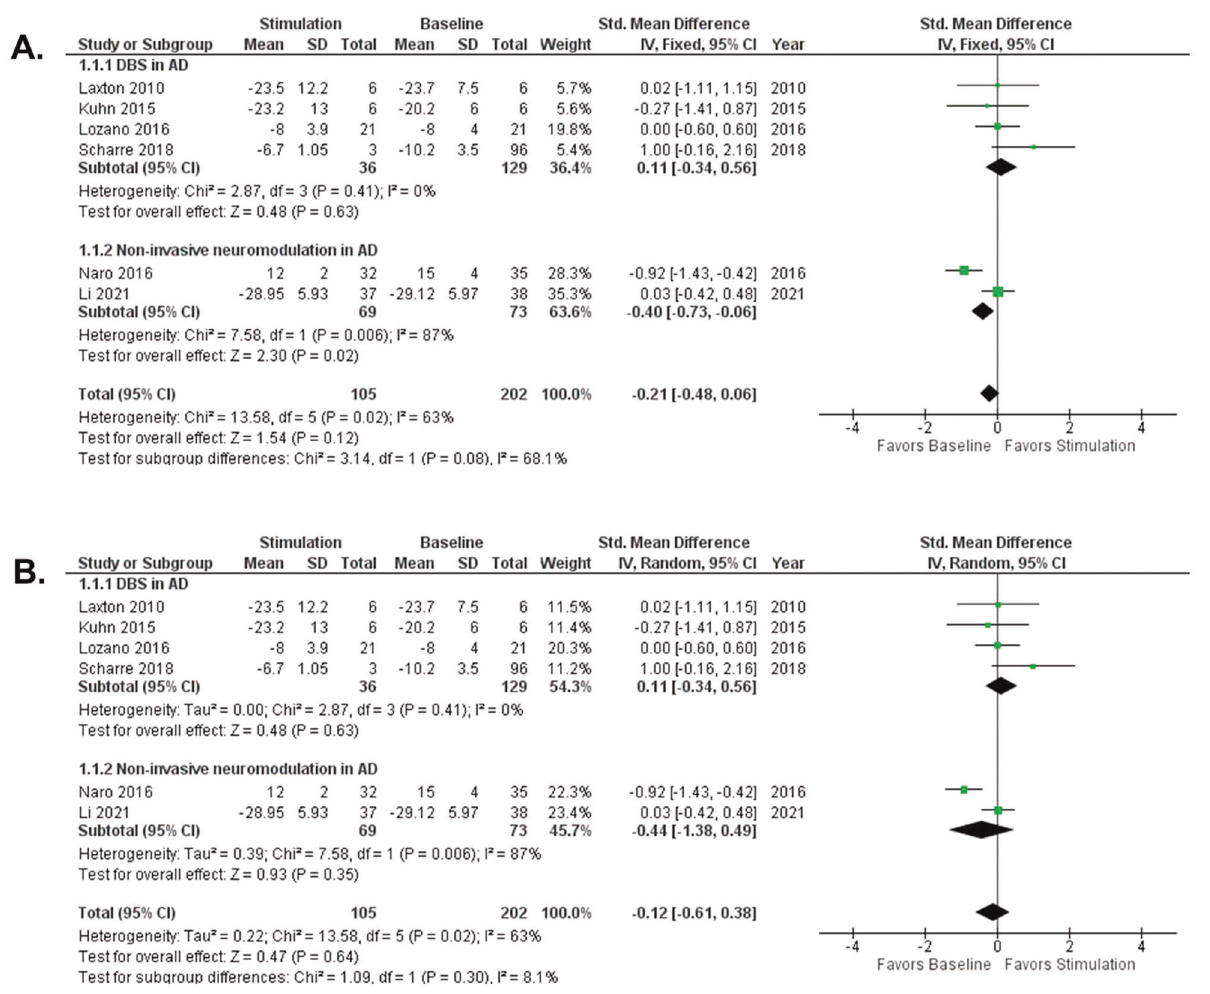
Fig. 2 Meta-analysis forest plots. A Fixed-effect model of meta-analysis of cognitive outcome after DBS and non-invasive neuromodulation in AD. B Random-effects model of meta-analysis of cognitive outcome after DBS and non-invasive neuromodulation in AD. AD Alzheimer ’ s disease, CI con fi dence interval, IV inverse variance, SD standard